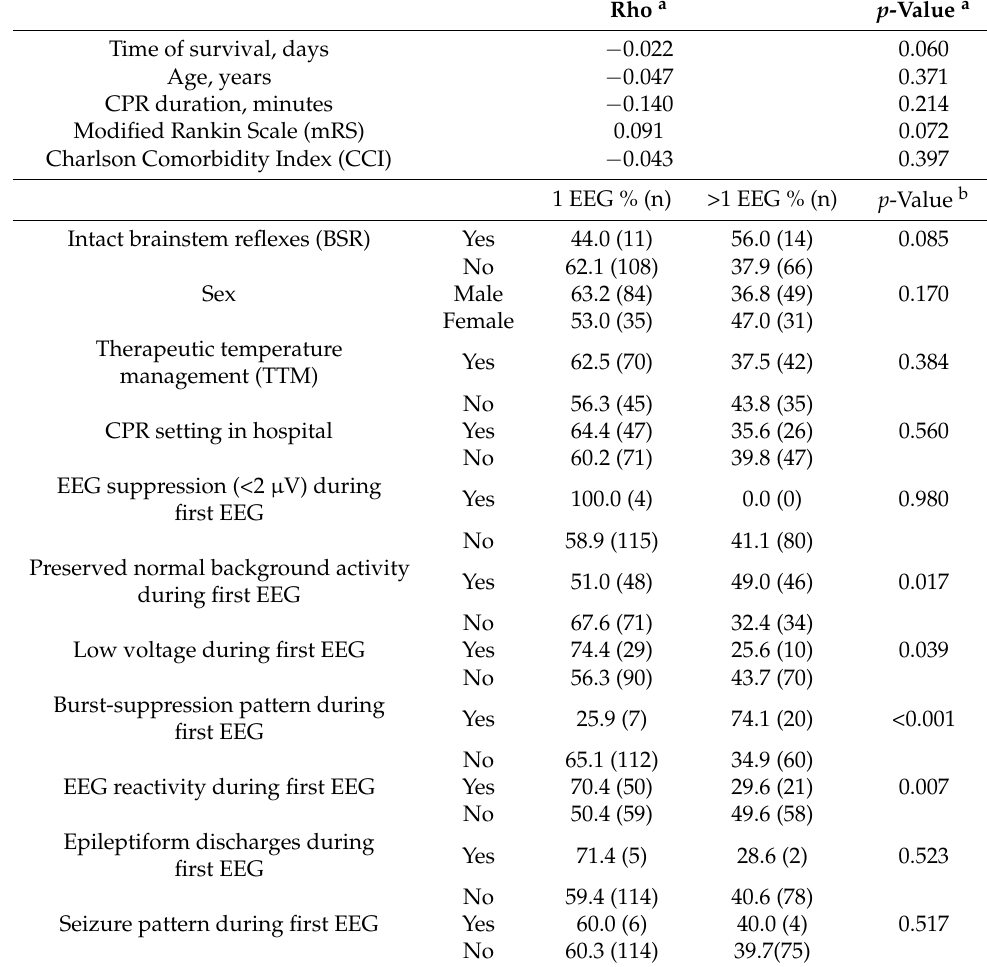
Table 1. Univariate analysis of factors leading to multiple EEG recordings in HE patients (n =